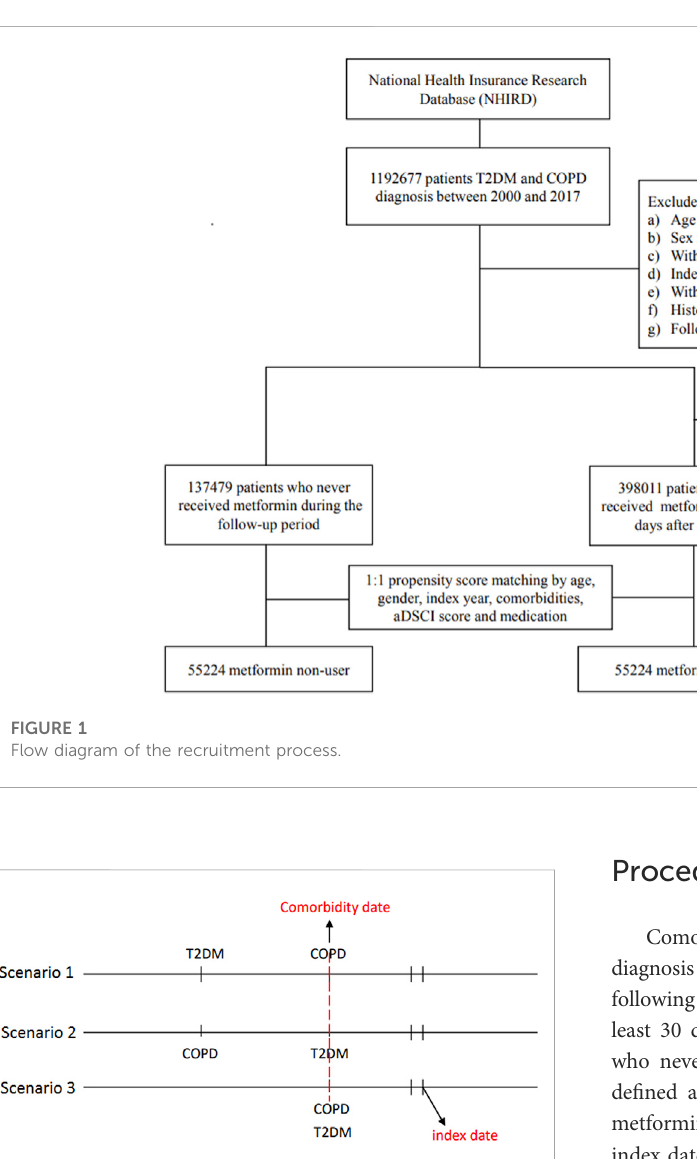
FIGURE 2 The concurrentdiagnosis of T2DM and COPD wasde fi ned as the comorbidity date. The fi rst date of metformin use after the comorbidity date was de fi ned as the index